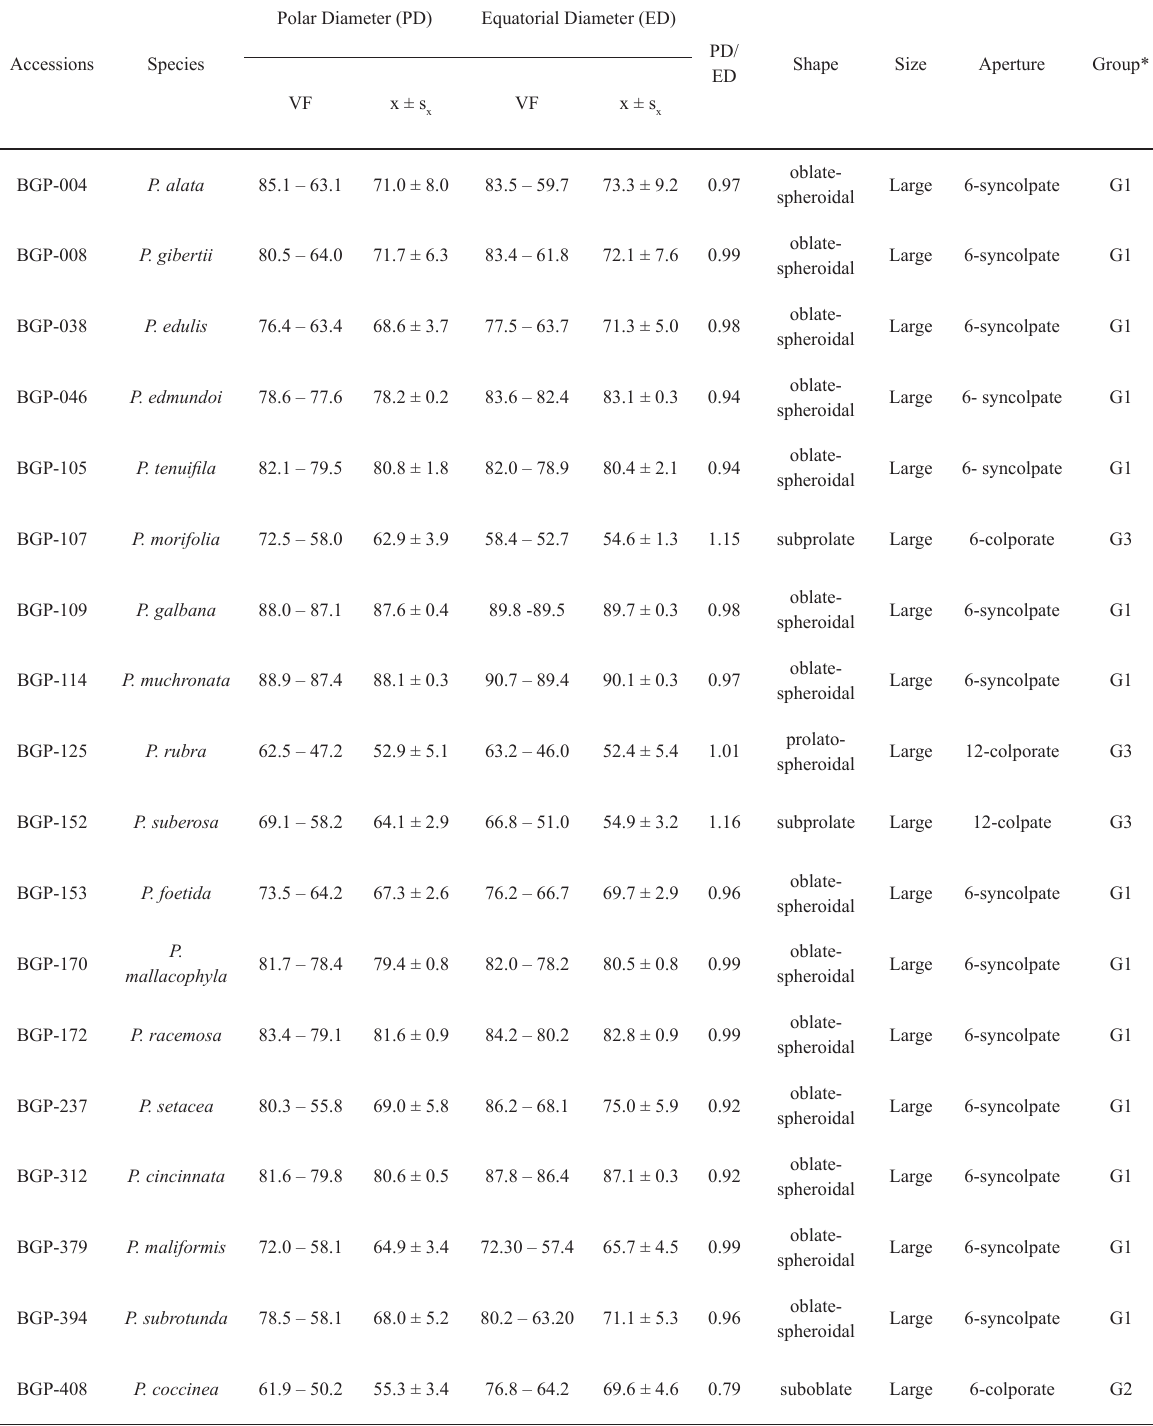
Morphopollinic characterization of 18 Passiflora s pecies belonging to the subgenera Passiflora and